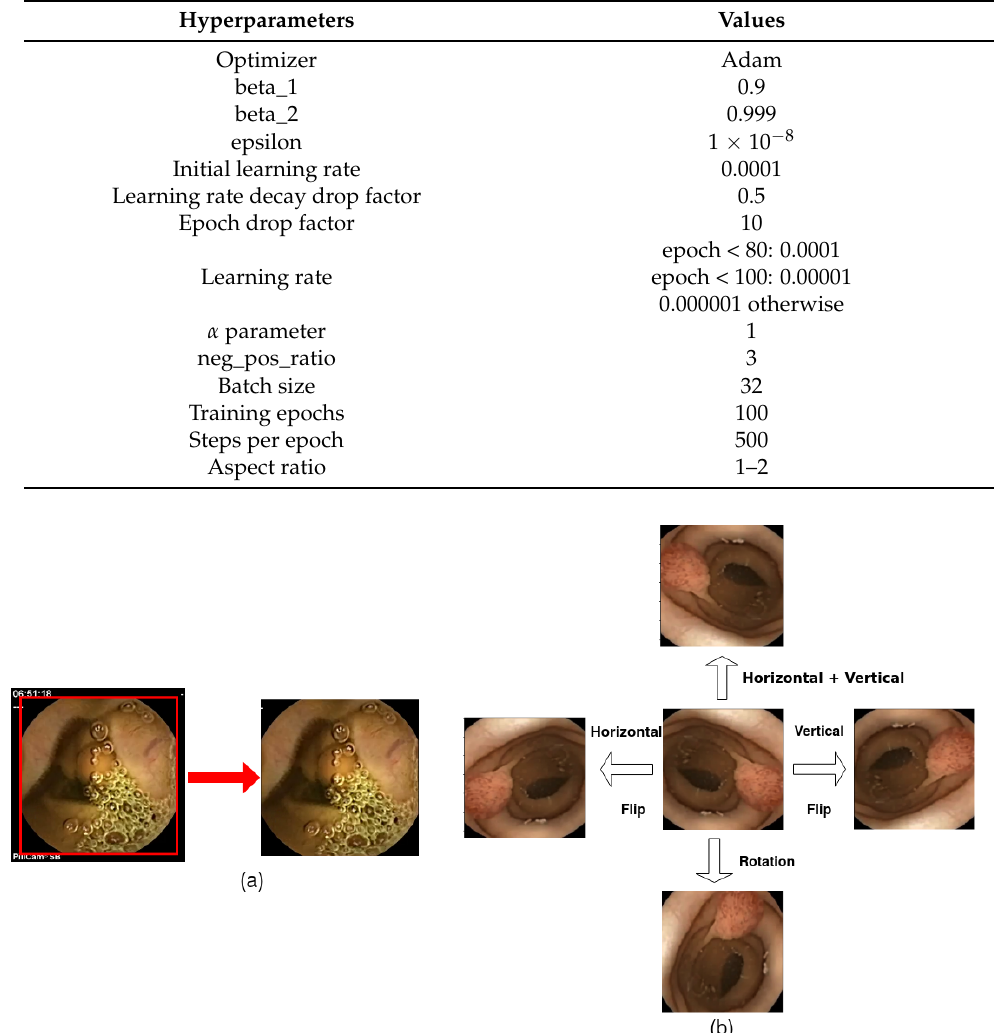
Figure 7. A flow-chart of the preprocessing steps: ( a ) acquiring the region of interest (ROI) of the WCE polyp image ( b ); sample of image from the WCE dataset with geometric